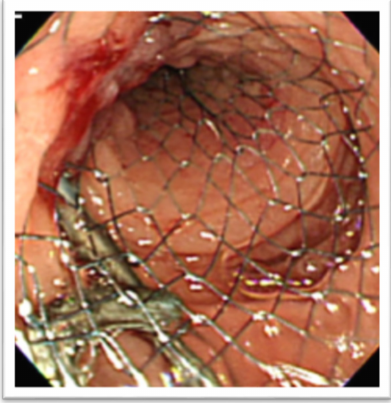
Figure 11. Duodenal self-expandable metal stent (SEMS).